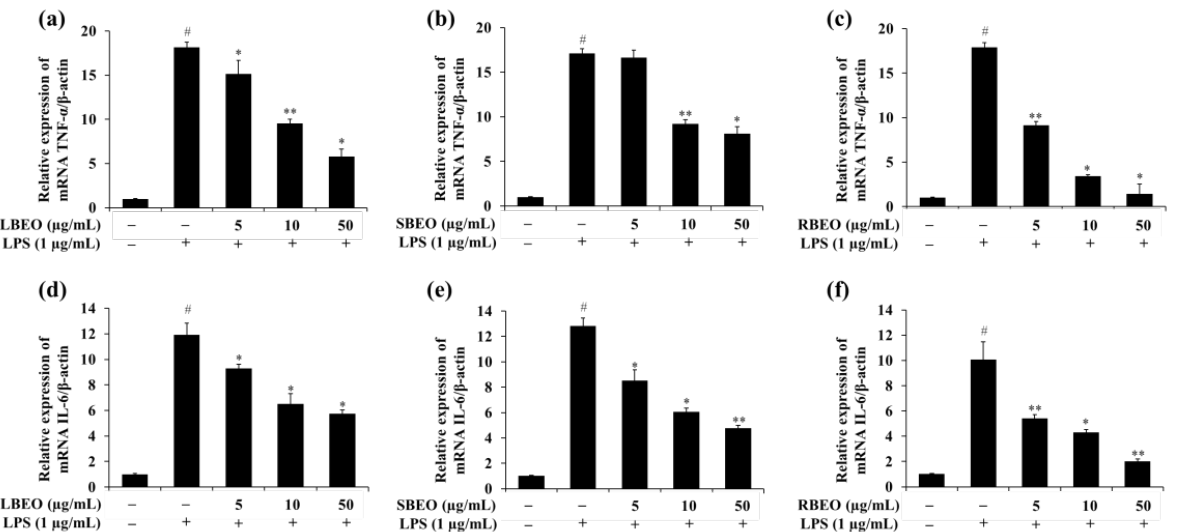
Figure 5. Effect of BEOs on the TNF- α and IL-6 mRNA levels of macrophages. Effects of ( a ) BLEO, ( b ) SBEO, and ( c ) RBEO on the TNF- α mRNA expression and effects of ( d ) BLEO, ( e ) SBEO, and ( f ) RBEO on the IL-6 mRNA expression in RAW 264.7 cell model after LPS stimulation were analyzed by qRT-PCR. The β -actin mRNA level was used as the interior standard to normalize the data, and the results were compared with those for the untreated cells. Data from three independent experiments were used to calculate mean values and standard deviation; # p < 0.05 vs. the LPS-untreated cells group, * p < 0.05, and ** p < 0.01 vs. the LPS-treated cells group.